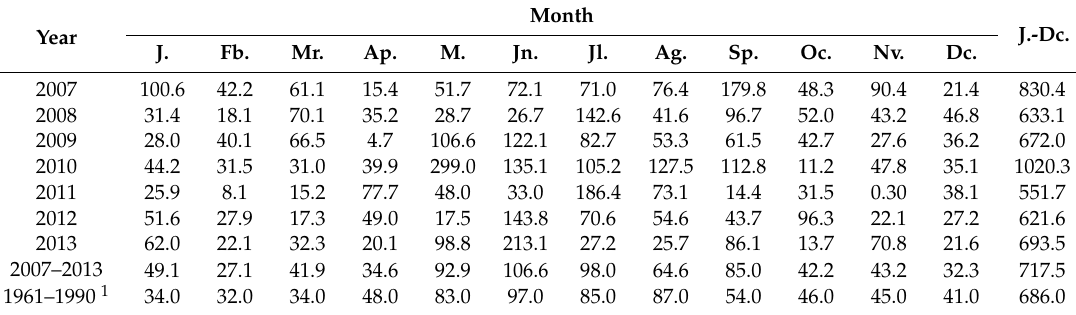
Table 2. Sum of precipitation (mm) during the course of